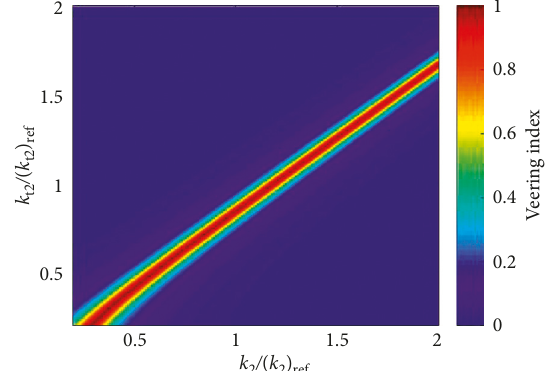
Figure 8: Veering index of the fourth and fifth modes with respect to k 2 and k t2 .